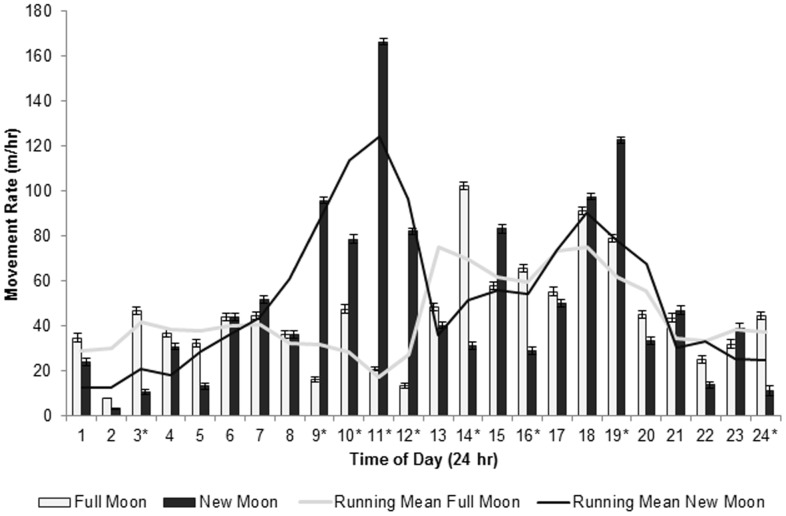
Mean hourly movement rates (± standard error) by bobcats during full and new moon periods.Movement rates were averaged for 5 bobcats at Bull Neck Swamp Research Forest, North Carolina from March 2008 and October 2009 and include 5 days surrounding new moon or full moon periods for each month. Lines indicate the running average mean for movement rates during new (gray line) and full (black line) moon periods. An * above the Time of Day indicates a significant difference (P<0.05) in movement rates between new and full moon periods.